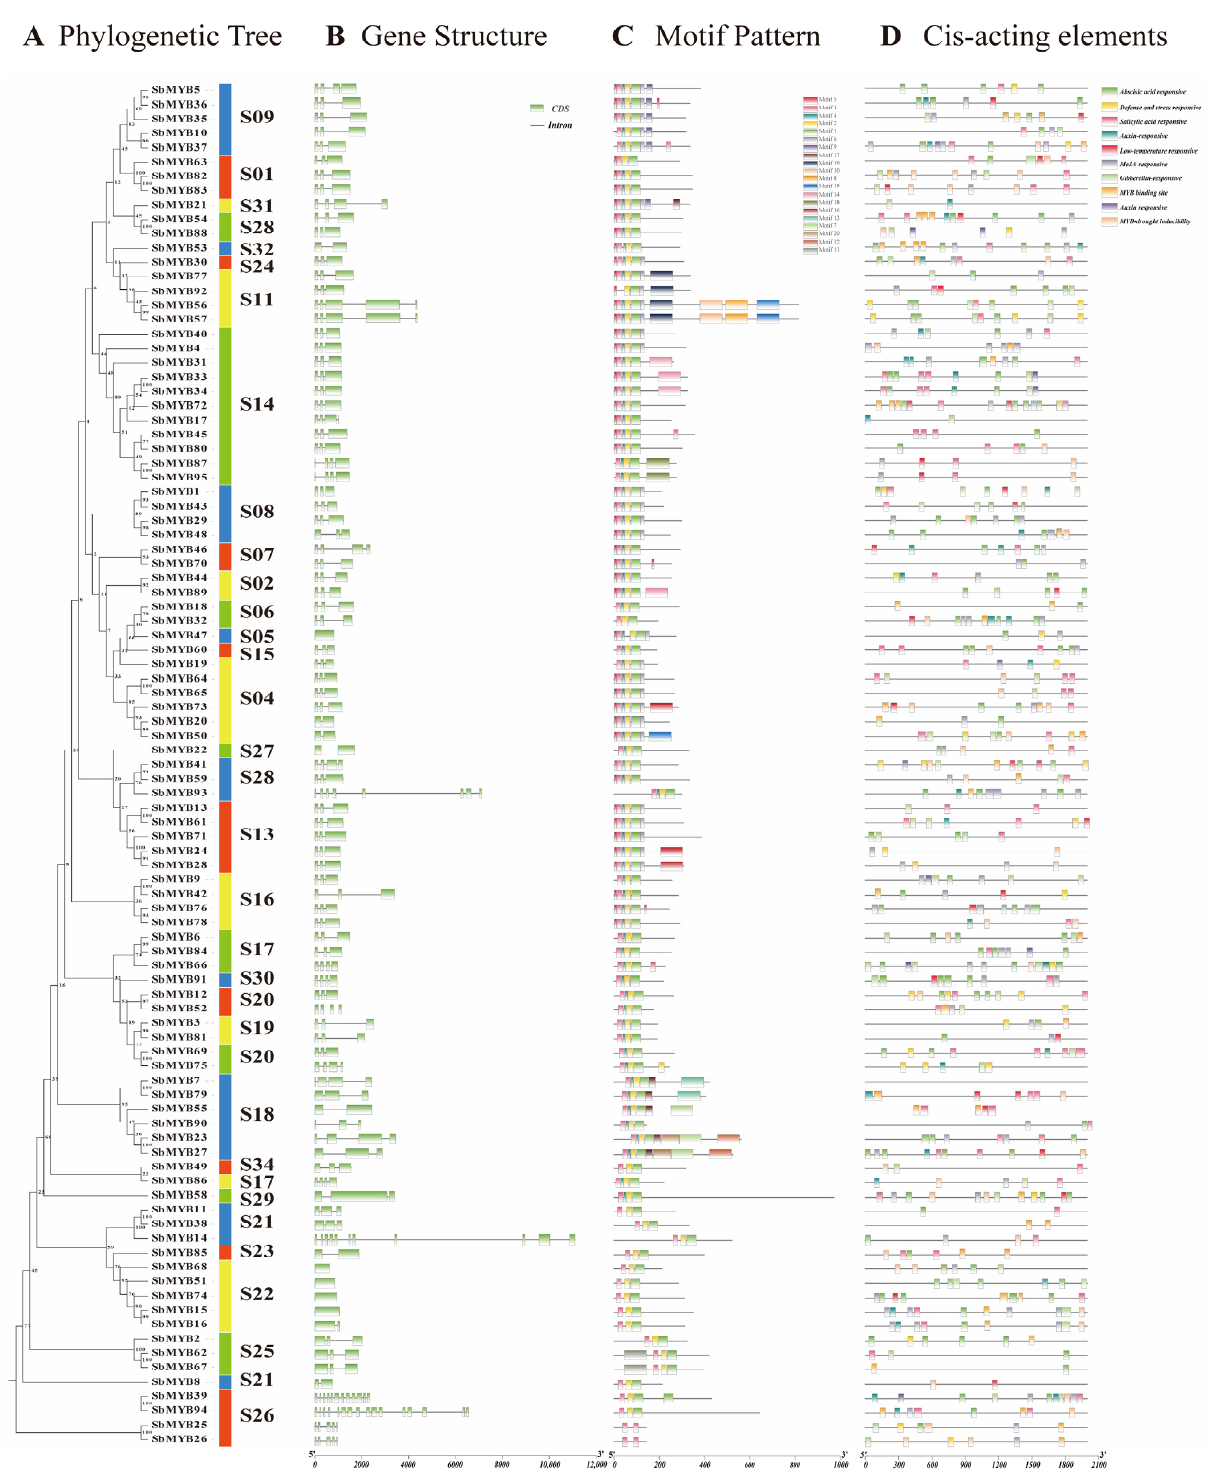
Figure 6. Phylogenetic analysis of the gene structures, conserved protein motifs, and cis-acting elements of R2R3-MYBs from S. baicalensis . ( A ) Phylogenetic tree of the R2R3- Sb MYB proteins. ( B ) Structures of R2R3-SbMYB genes are depicted with green boxes for exons and gray lines for introns. ( C ) A total of 20 motif compositions of the R2R3- Sb MYB proteins are represented via differently colored boxes. ( D ) Analysis of R2R3-SbMYB gene promoters for cis-acting